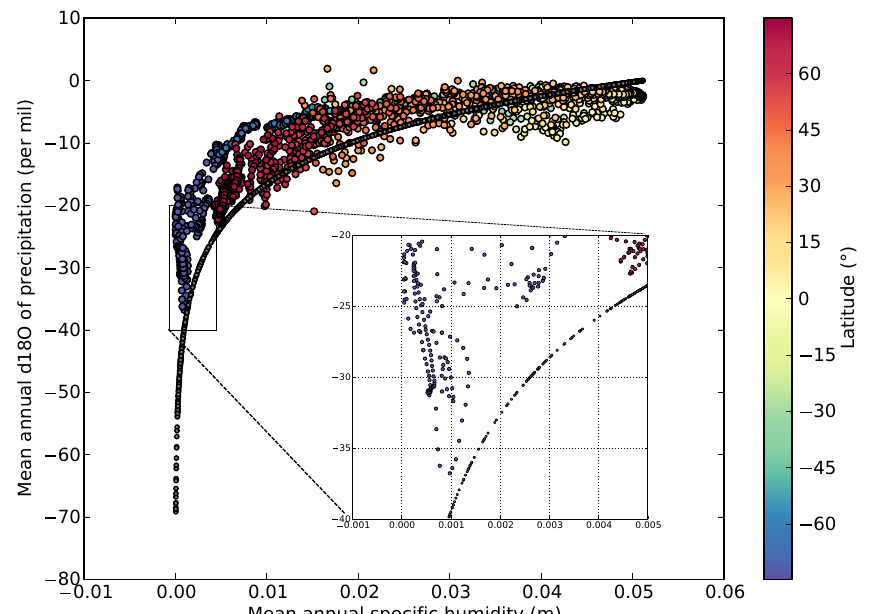
Fig. 2. δ 18 O – humidity relationship in i LOVECLIM compared to a theoretical Rayleigh distillation model. The colour scale applied to model points indicates the latitude. The Rayleigh distillation curve is given for a temperature of 15 ◦ C starting from an oceanic-like value of 0 per mil, as an example. The inset details the anomalous humidity values discussed in the